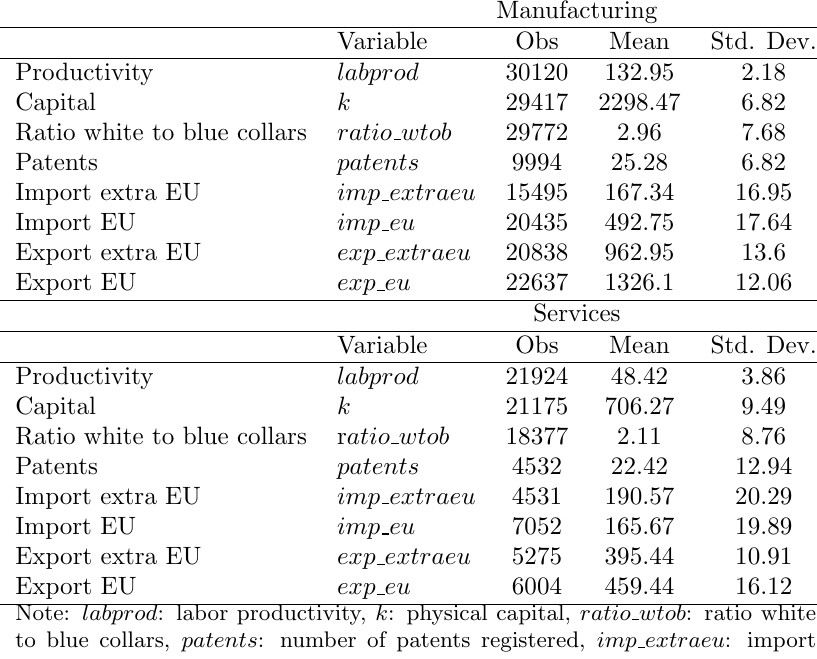
Descriptive Statistics for Manufacturing and Services